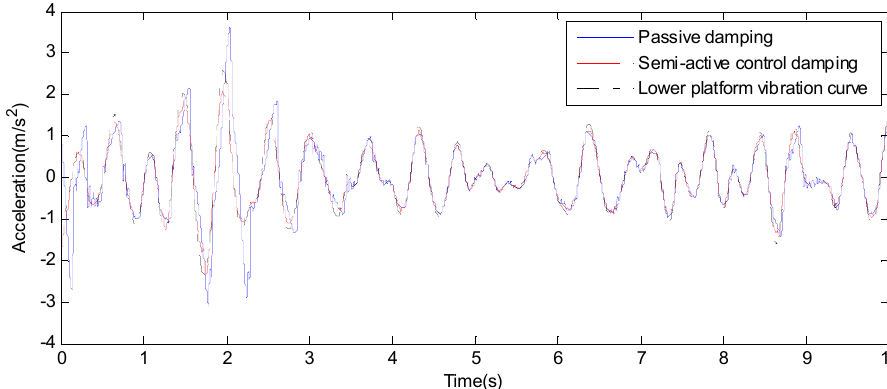
Figure 26. The z -axis direction simulation results.